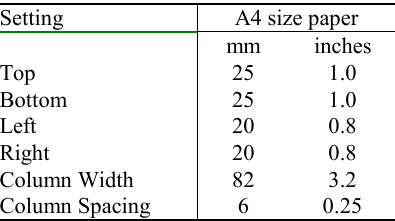
Table 1. Margin settings for A4 size paper